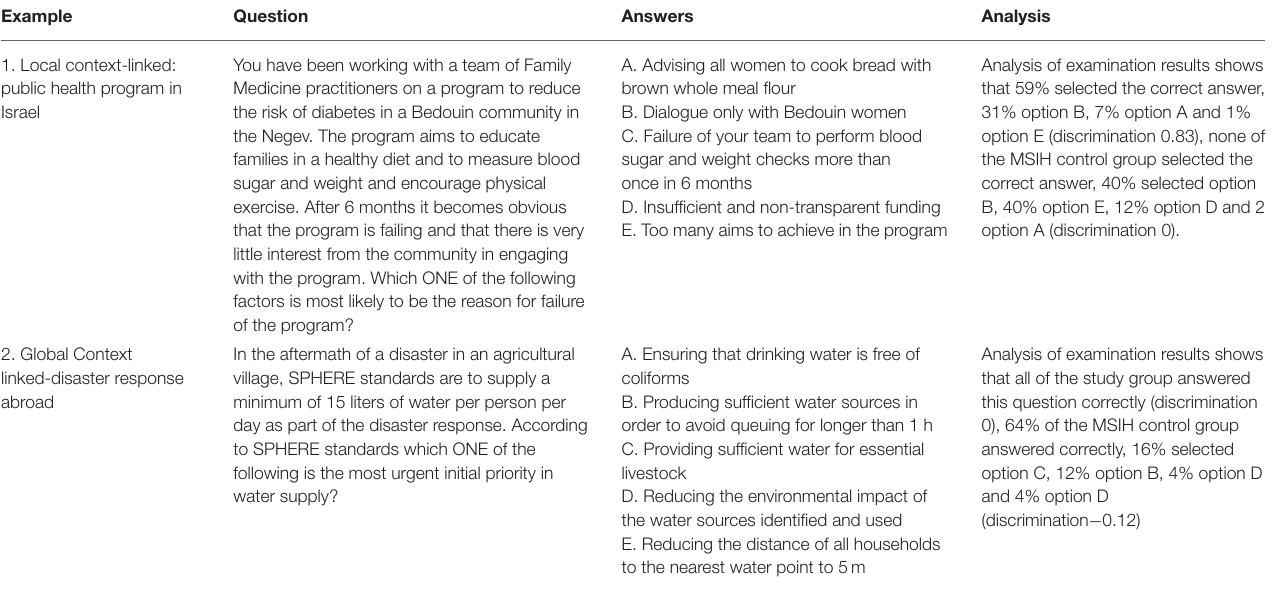
TABLE 3 | Examples of global health MCQ assessment